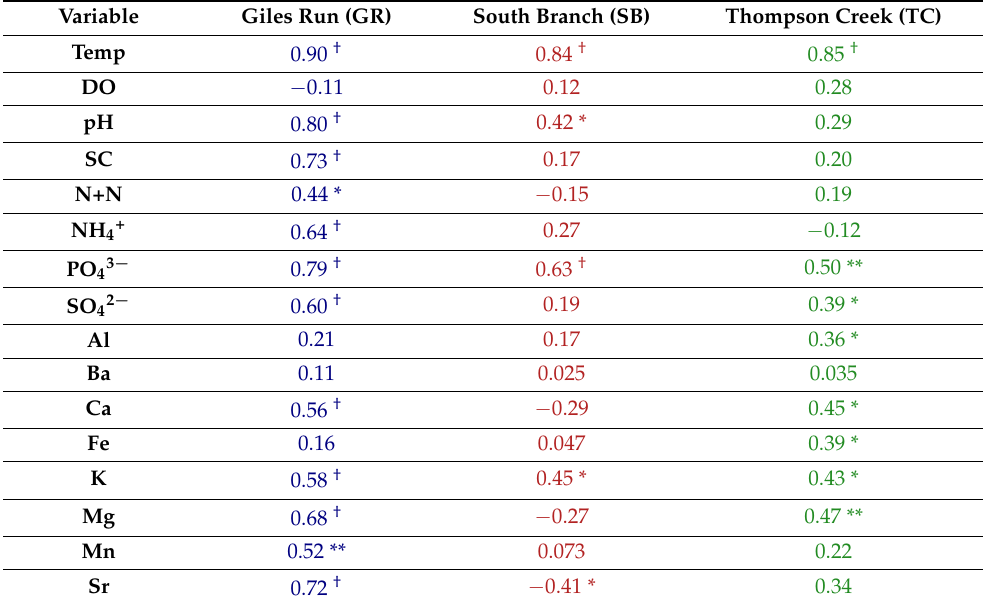
Table 5. Spearman correlation coefficients for surface water-subsurface water in each stream